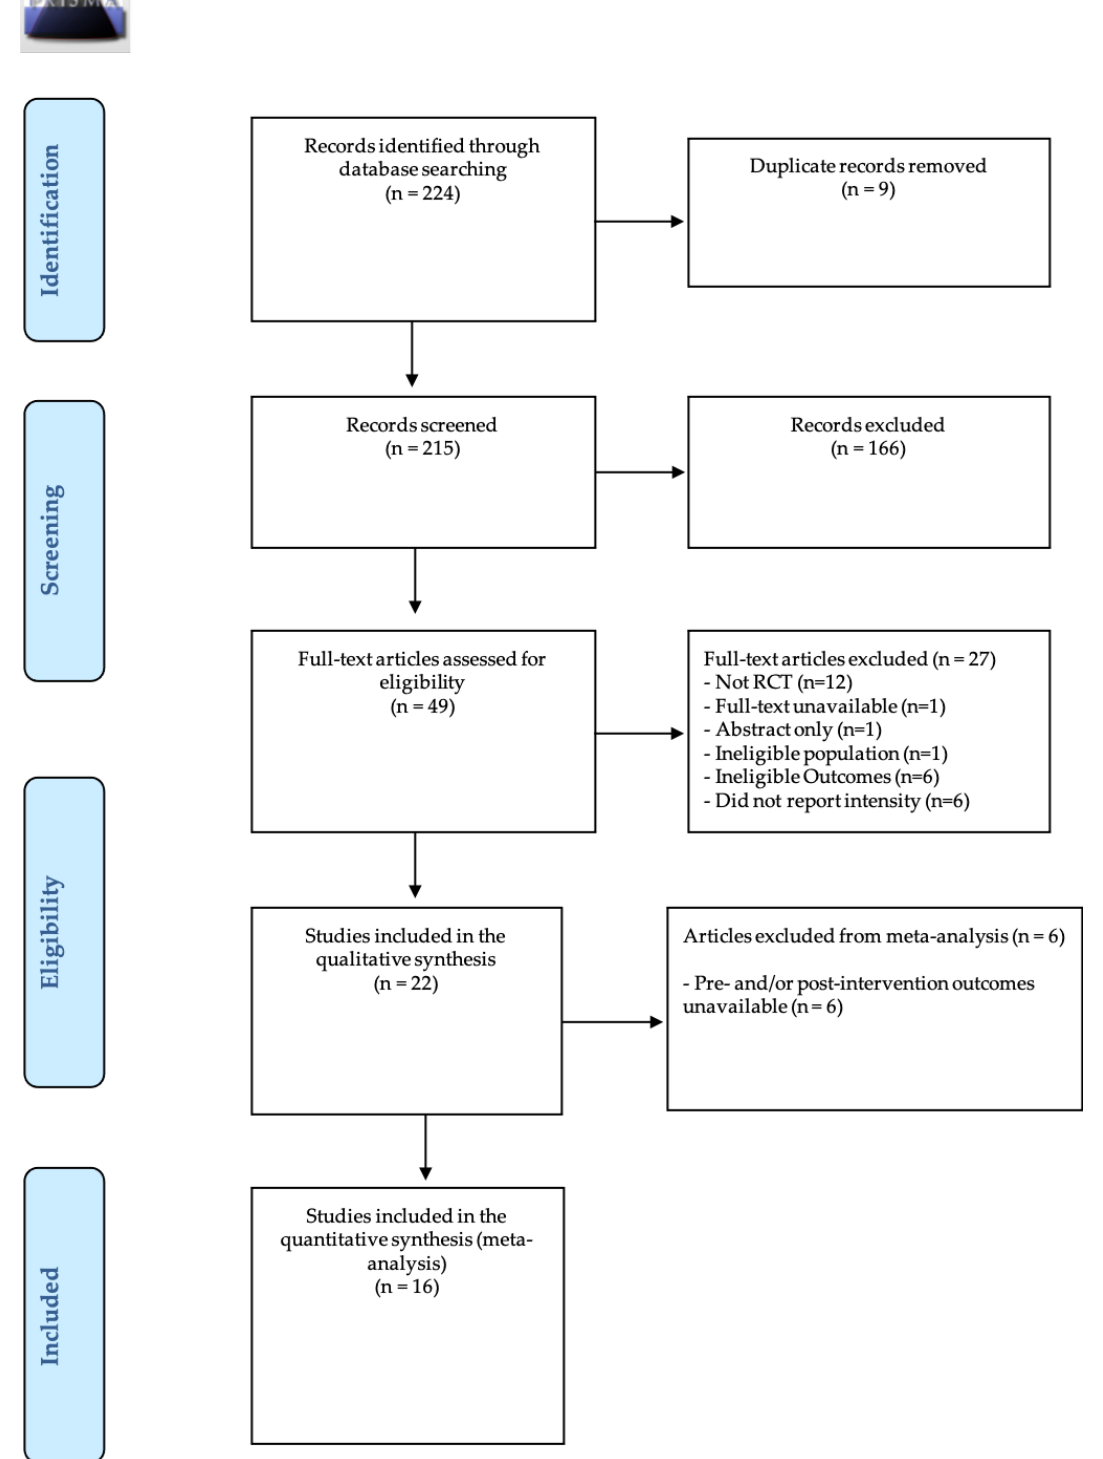
Figure 1. Preferred Reporting Items for Systematic Reviews and Meta-analysis (PRISMA) diagram of literature search strategies.